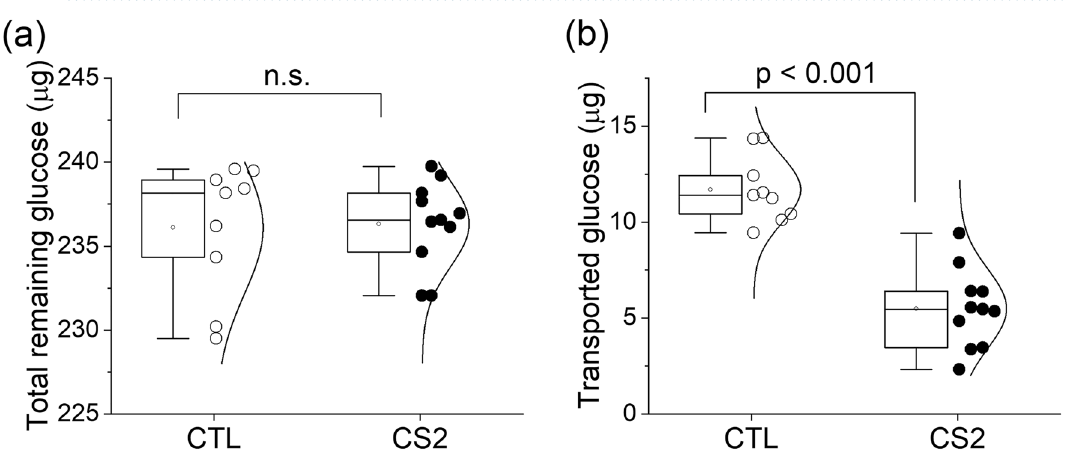
Figure 5. ( a ) Total glucose remained in the device, determined as the sum of glucose amount in both trophoblast and endothelial channels. n.s.—not significant. ( b ) Amount of glucose transported across the modeled placental